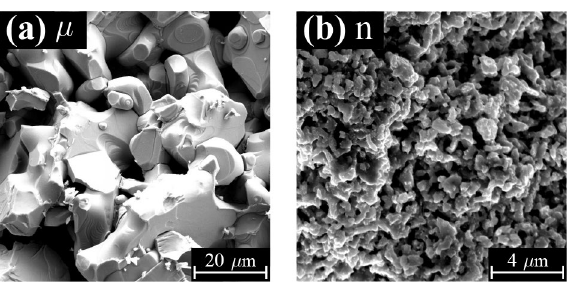
Figure 1. SEM images of the µ - ( a ) and n-YBCO ( b ) target surfaces, which give a clear indication of different grain sizes of the targets (note the different in-plane